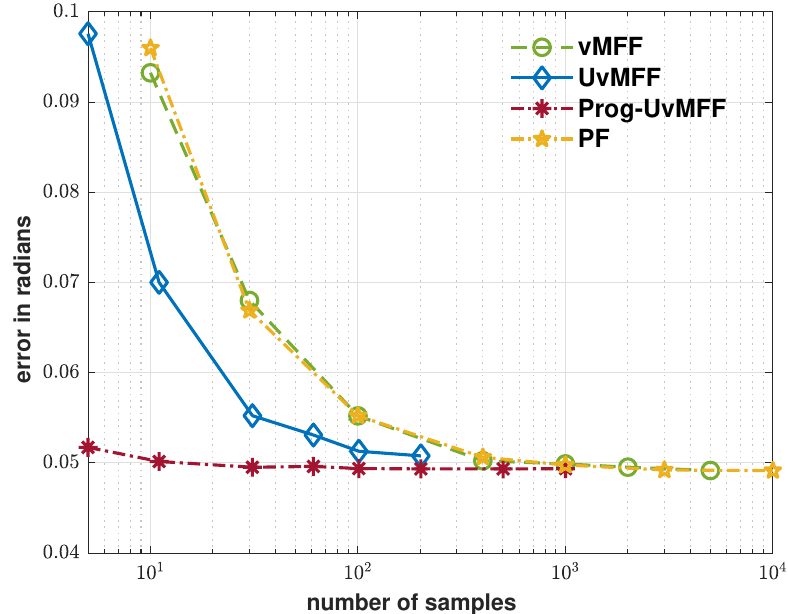
Figure 4. Error over sample numbers (log scale) for the evaluated filters. The configurations with five samples for UvMFF and Prog-UvMFF are based on the original UT-based sampling method in